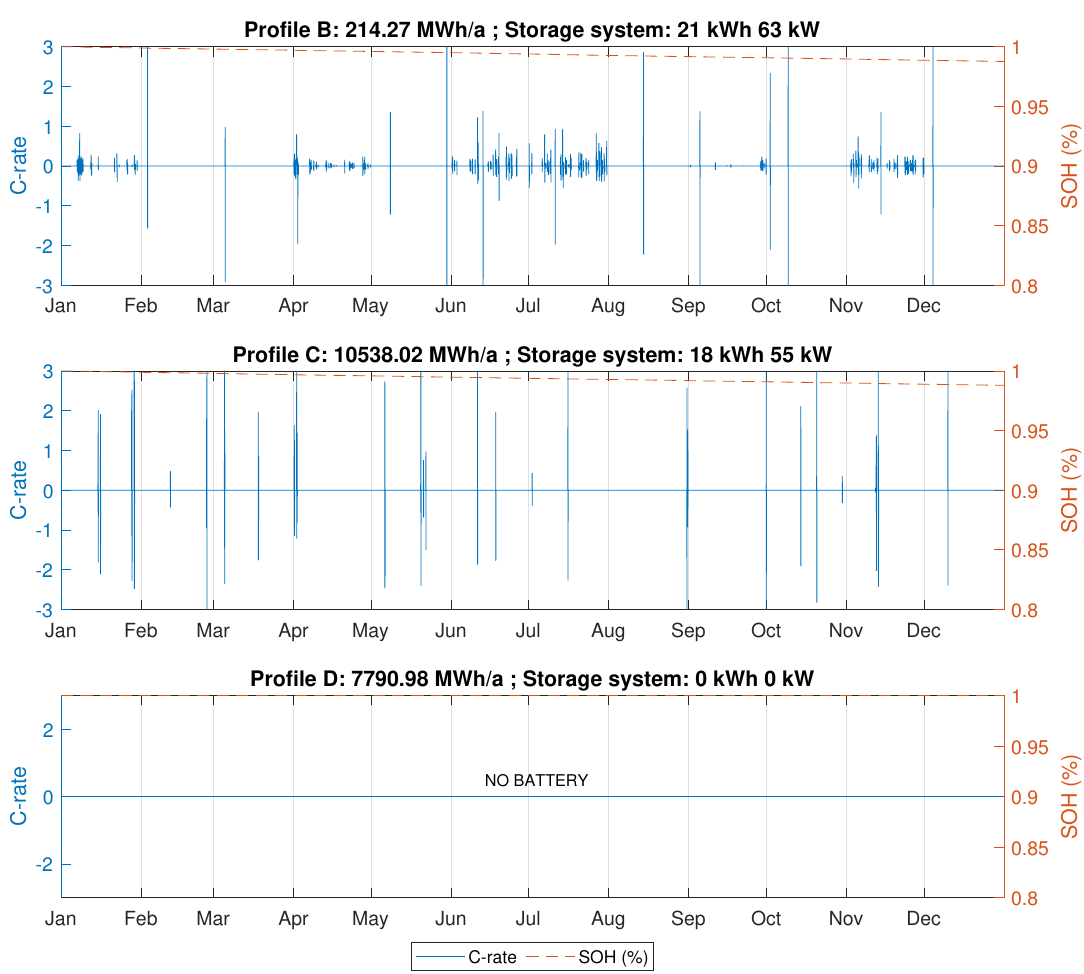
Figure A2. Battery power profile with monthly billing scheme and resulting state of health